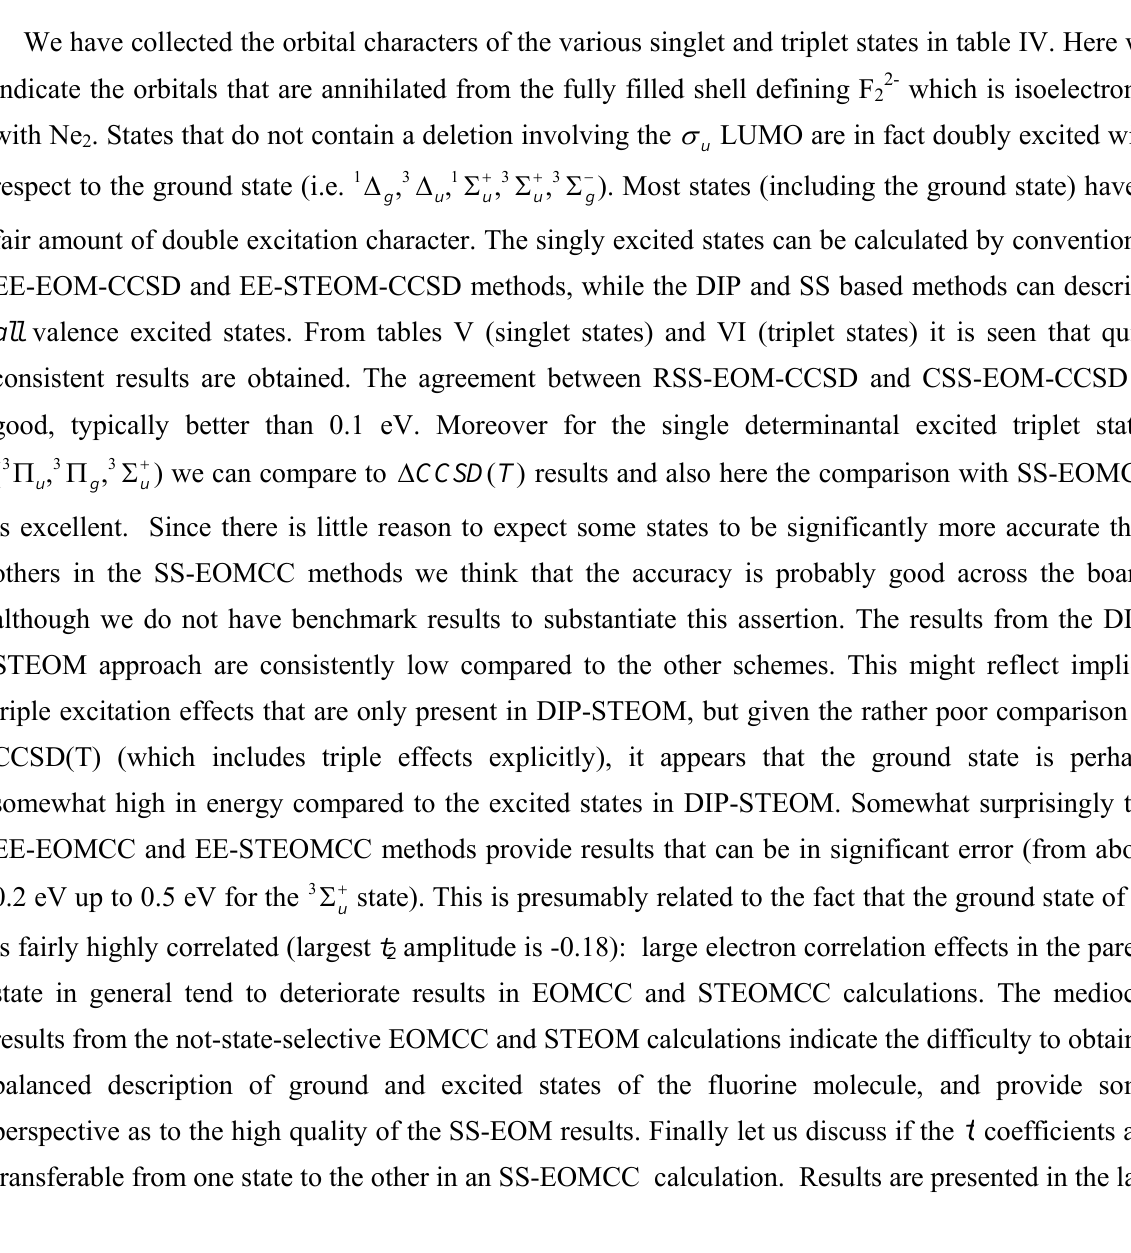
Table III. Ground state properties for F Method